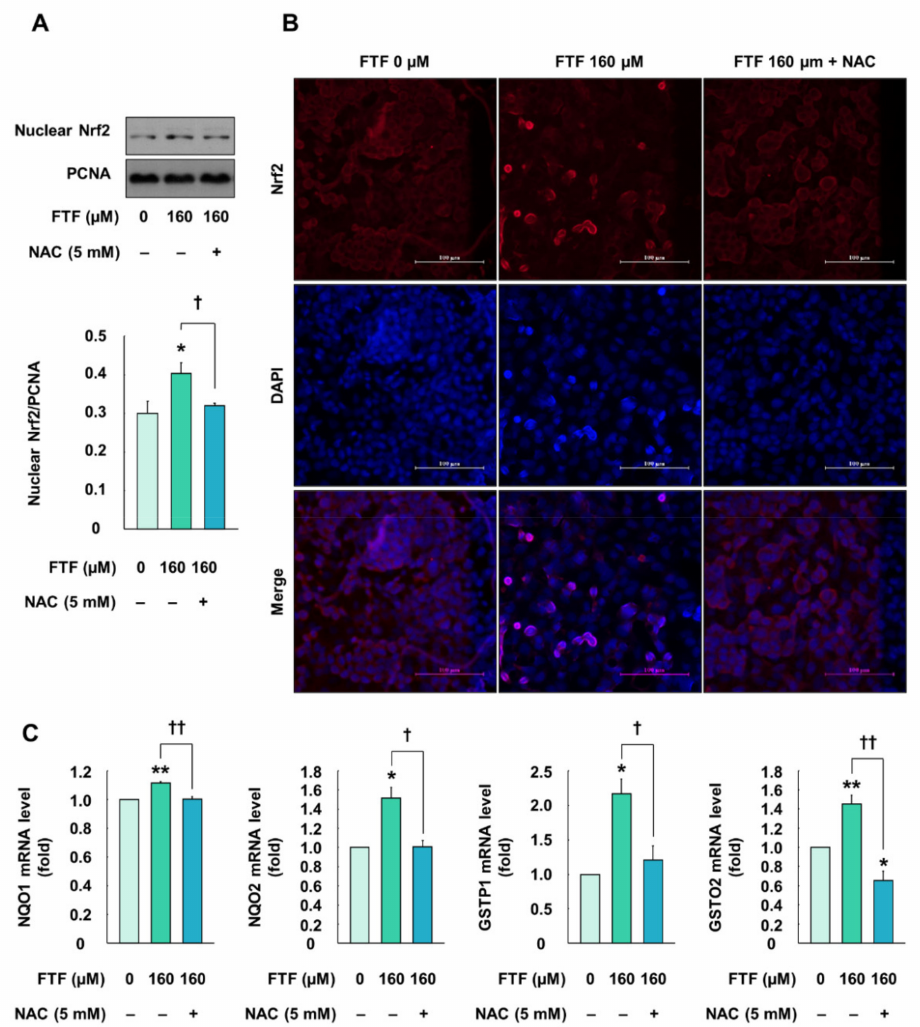
Figure 4. Effects of FTF on Nrf2 translocation and gene expression of antioxidant enzymes in HepG2 cells: ( A ) nuclear translocation and ( B ) fluorescence image of Nrf2 in HepG2 cells. The magnification of the image was 400 × ; ( C ) gene expression of antioxidant enzymes, including NQO1, NQO2, GSTP1, and GSTO2 in HepG2 cells. The cells were treated with 160 µ M FTF for 24 h with 5 mM NAC pretreatment for 1 h ( n = 3 wells per group). PCNA and GPADH were used as housekeeping protein and gene. Images are representative of three independent experiments. The results are expressed as mean ± SEM and statistically significant differences, as compared with the control (DMSO), are indicated as * P < 0.05 and ** P < 0.01. † P < 0.05 and †† P < 0.01 indicate a significant difference, compared with the 160 µ M